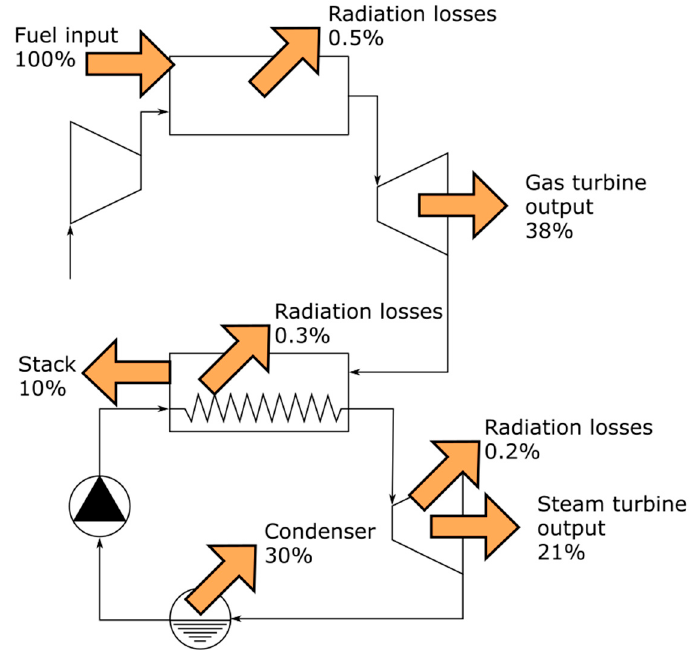
Figure 23. Energy balance in a combined cycle (data source: [29]).